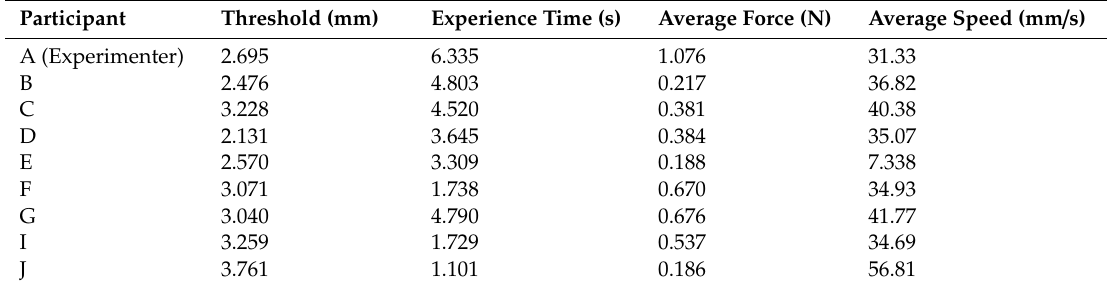
Table 2. Finger behavior and threshold for each participant. Participant H was omitted because the data were not successfully